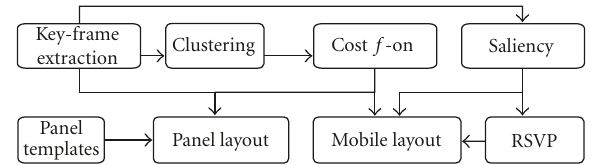
Figure 1: Block scheme of the video summarisation system. For the both layout modules, key-frame sizes are being estimated. The saliency based cropping is applied only in case of mobile